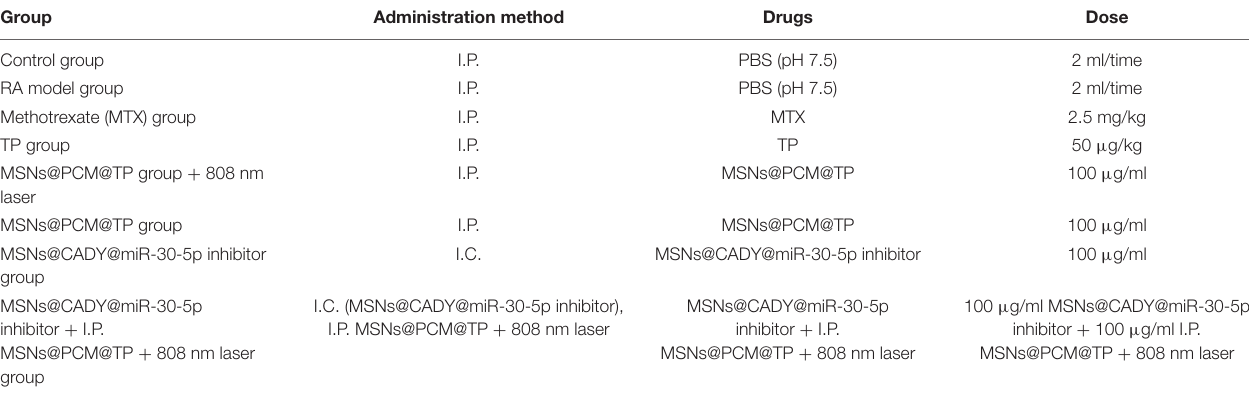
TABLE 1 | The appropriate dose and method of administration in rats. Group Administration method Drugs Dose Control group RA model